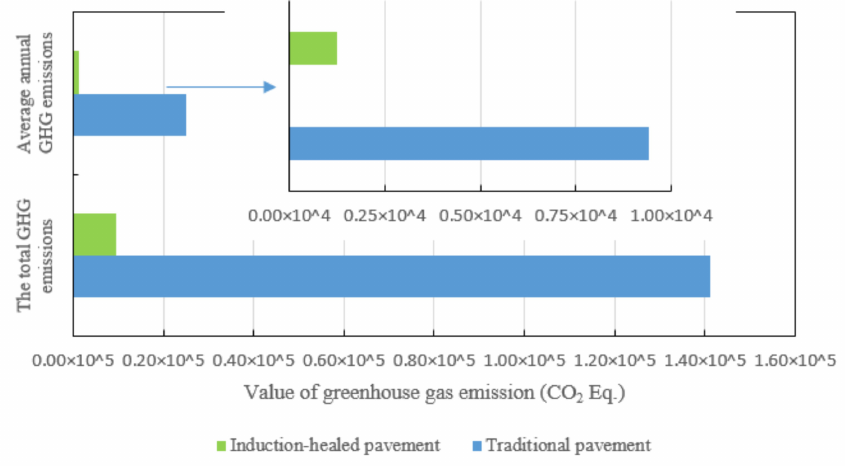
Figure 13. Greenhouse gas emissions of two asphalt pavements’ maintenance in their design